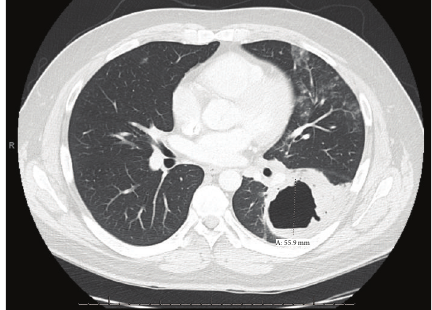
Figure 2: Chest computed tomography of left lower lobe superior segment cavitary lesion with air fluid level, largest diameter 5.59 cm.